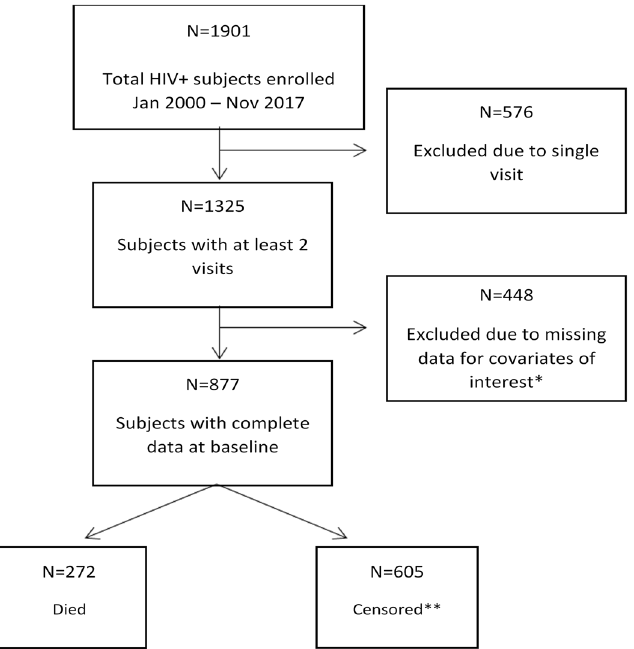
Figure 1. Flow chart of participation. *Descriptive analysis comparing those with missing data for covariates of interest to those with complete data showed no difference in demographic variables and baseline global T scores. **There is a 12% loss to